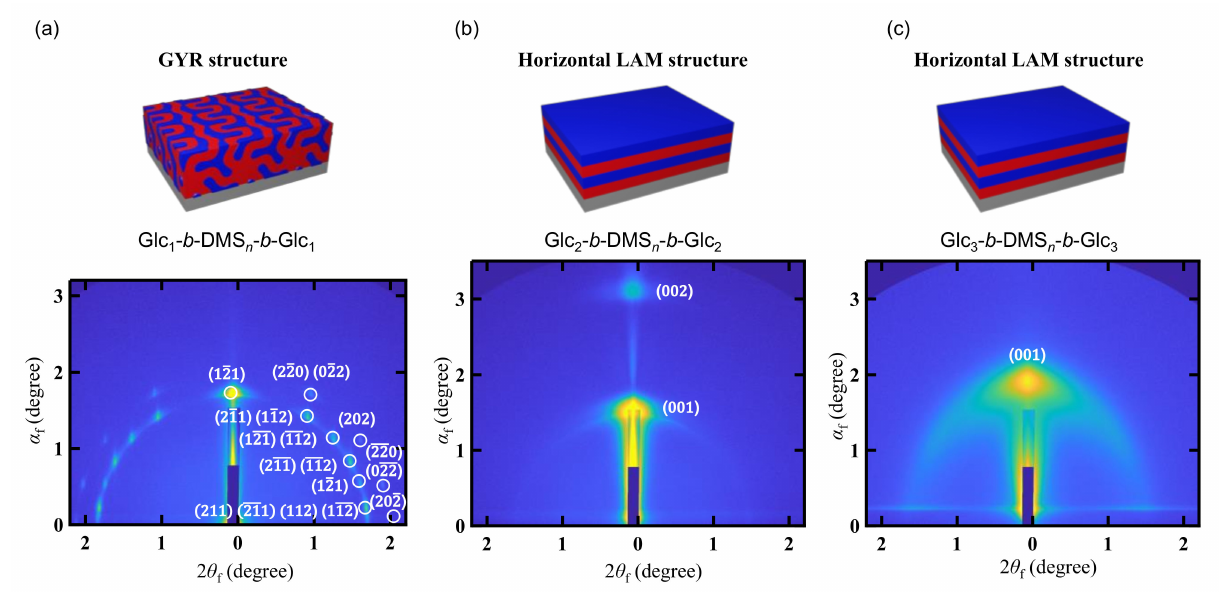
Figure 3. GISAXS images of ( a ) Glc 1 - b -DMS n - b -Glc 1 , ( b ) Glc 2 - b -DMS n - b -Glc 2 , and ( c ) Glc 3 - b -DMS n - b -Glc 3 thin films. All samples were prepared by spin coating 5.0 wt% DMF solutions onto silicon substates and subsequent thermal annealed at 80 ◦ C for 6